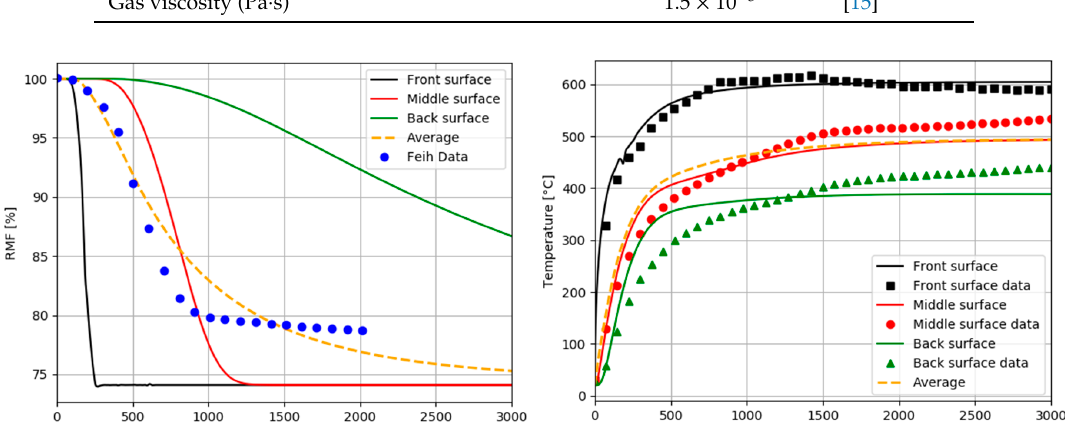
Figure 3. Remaining mass fraction (RMF) profiles and temperature profiles. Comparison between our numerical simulation predictions (label surface) as a function of time to the experimental data of Feih et al. [24] (label surface data) for an E-glass/vinyl ester composite laminate exposed to a heat flux of 50 kW/m 2.